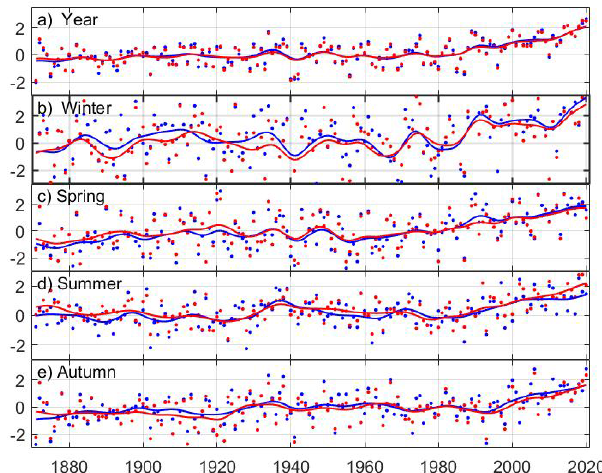
Figure 7. Annual and seasonal mean near-surface air temperature anomalies for the Baltic Sea basin for 1871–2020. The baseline period is 1961–1990. Blue and red show the Baltic Sea basin re- gion north and south, respectively, of 60 ◦ N. Dots are the individ- ual years, and smoothed curves show the variability on timescales longer than 10 years. Data source: CRUTEM4v dataset (Jones et al.,